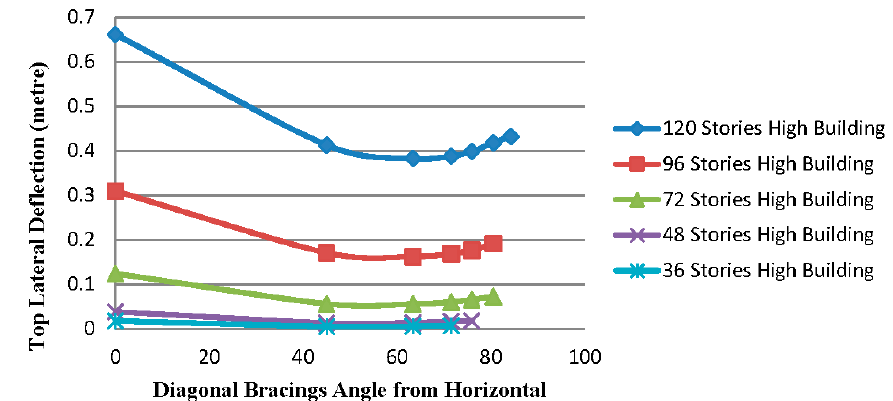
Figure 13. Top lateral deflection vs. varying angle of bracing system for buildings of Model 1.